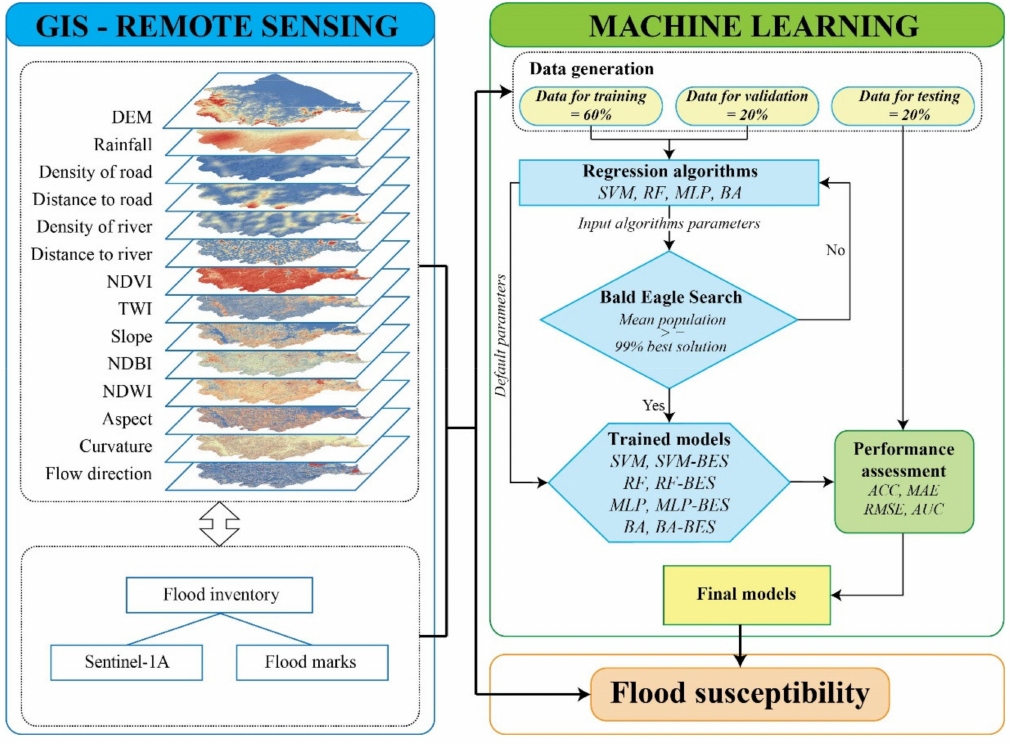
Figure 3. Flow chart of the flood susceptibility mapping